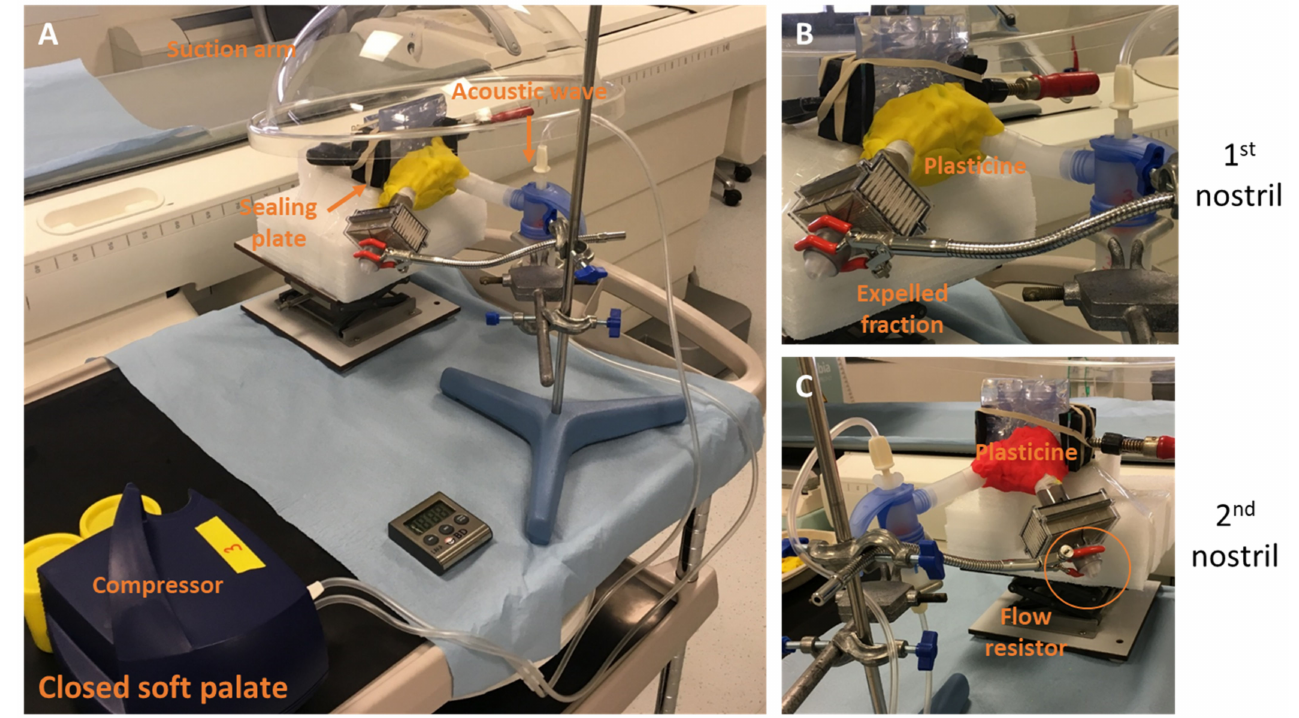
Figure 9. Experimental setup in the closed soft palate condition for 99m Tc-DTPA nebulization with the PARI SINUS device in the Nuclear Medicine Department under a suction arm. ( A ) The illustration shows the human replica assembly with closed soft palate and sealing of maxillary sinuses. ( B , C ) PALL Filter BB50TE with a flow resistor was used to collect the expelled fraction. The nebulization duration was fixed at 6 min (3 min in each nostril). Improved sealing was obtained using plasticine to avoid radioactivity